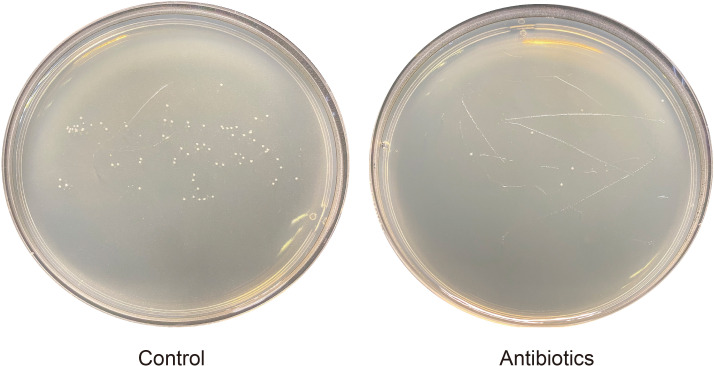
The gut microbiota from second-instar P. xylostella larvae were nearly killed by the antibiotic cocktail.The antibiotic cocktail contains 100 kU/mL penicillin, 100 mg/mL streptomycin, and 50 mg/mL gentamycin.
Figure 6—figure supplement 3—source data 1.The gut microbiota from second-instar P. xylostella larvae were nearly killed by the antibiotic cocktail.